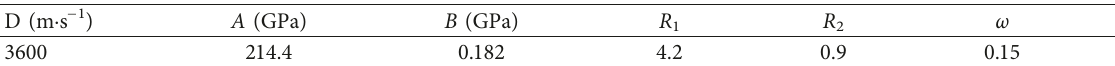
Table 6: Blasting parameters.